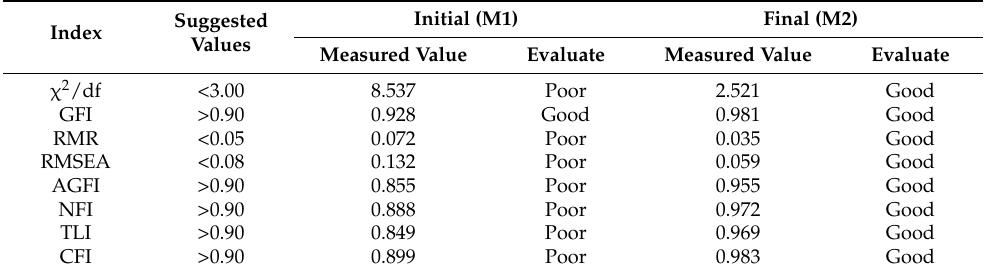
Table 4. Fitting index of the initial model (M1) and the adjusted structural equation model